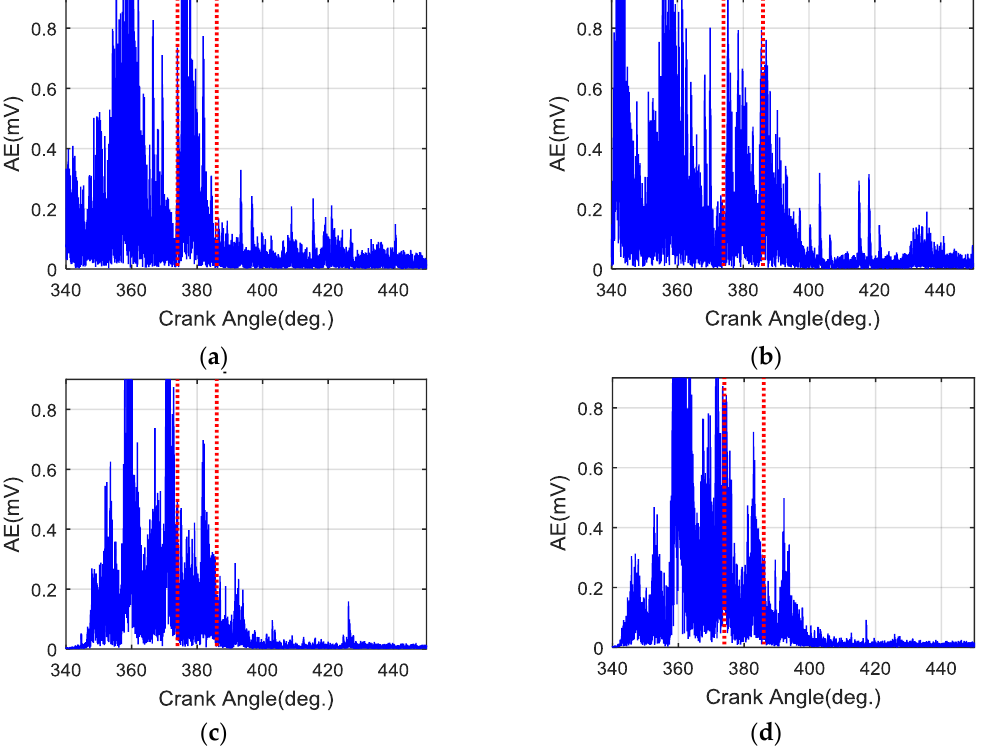
Figure 19. AE signal of liner under different operating conditions: ( a ) 1799 rpm–40 Nm; ( b ) 1799 rpm–40 Nm; ( c ) 1001 rpm–40 Nm; ( d ) 1001 rpm–10 Nm.